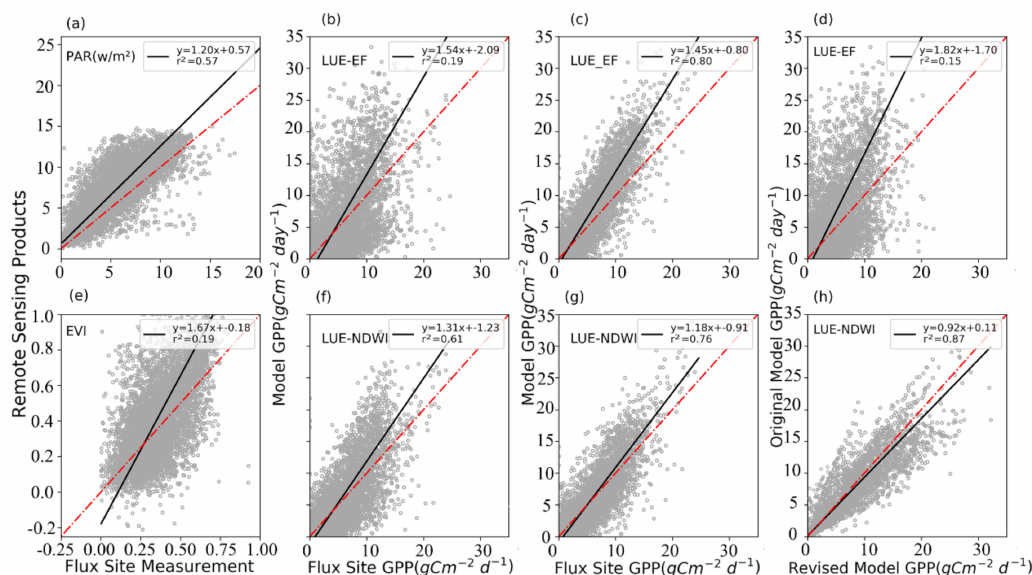
Figure 3. Comparison of ( a ) spatial PAR (photosynthetic active radiation) and site PAR, ( b ) tower GPP and LUE-EF GPP (uncorrected spatial data), ( c ) tower GPP and LUE-EF GPP (corrected spatial data), ( d ) LUE-EF GPP with uncorrected and LUE-EF GPP corrected spatial data, ( e ) spatial EVI (500 m resolution) and spatial EVI (10 km resolution), ( f ) tower GPP and LUE-NDWI GPP (uncorrected spatial data), ( g ) tower GPP and LUE-NDWI GPP (corrected spatial data), and ( h ) LUE-NDWI GPP with uncorrected and LUE-NDWI GPP corrected spatial data. All comparisons are based on site scale. Corrected spatial data were generated from the uncorrected ones after correcting their biases using orthogonality regression (see Section